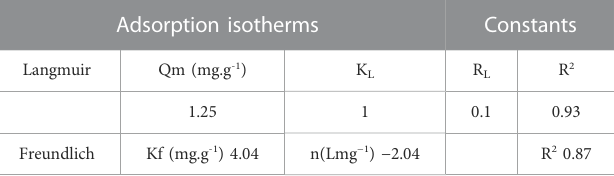
TABLE 3 Constant parameters and correlation co-ef fi cient calculated for Langmuir and Freundlich adsorption isotherm models at room temperature for MB adsorption at 10 (mgL − 1 ) at room temperature.